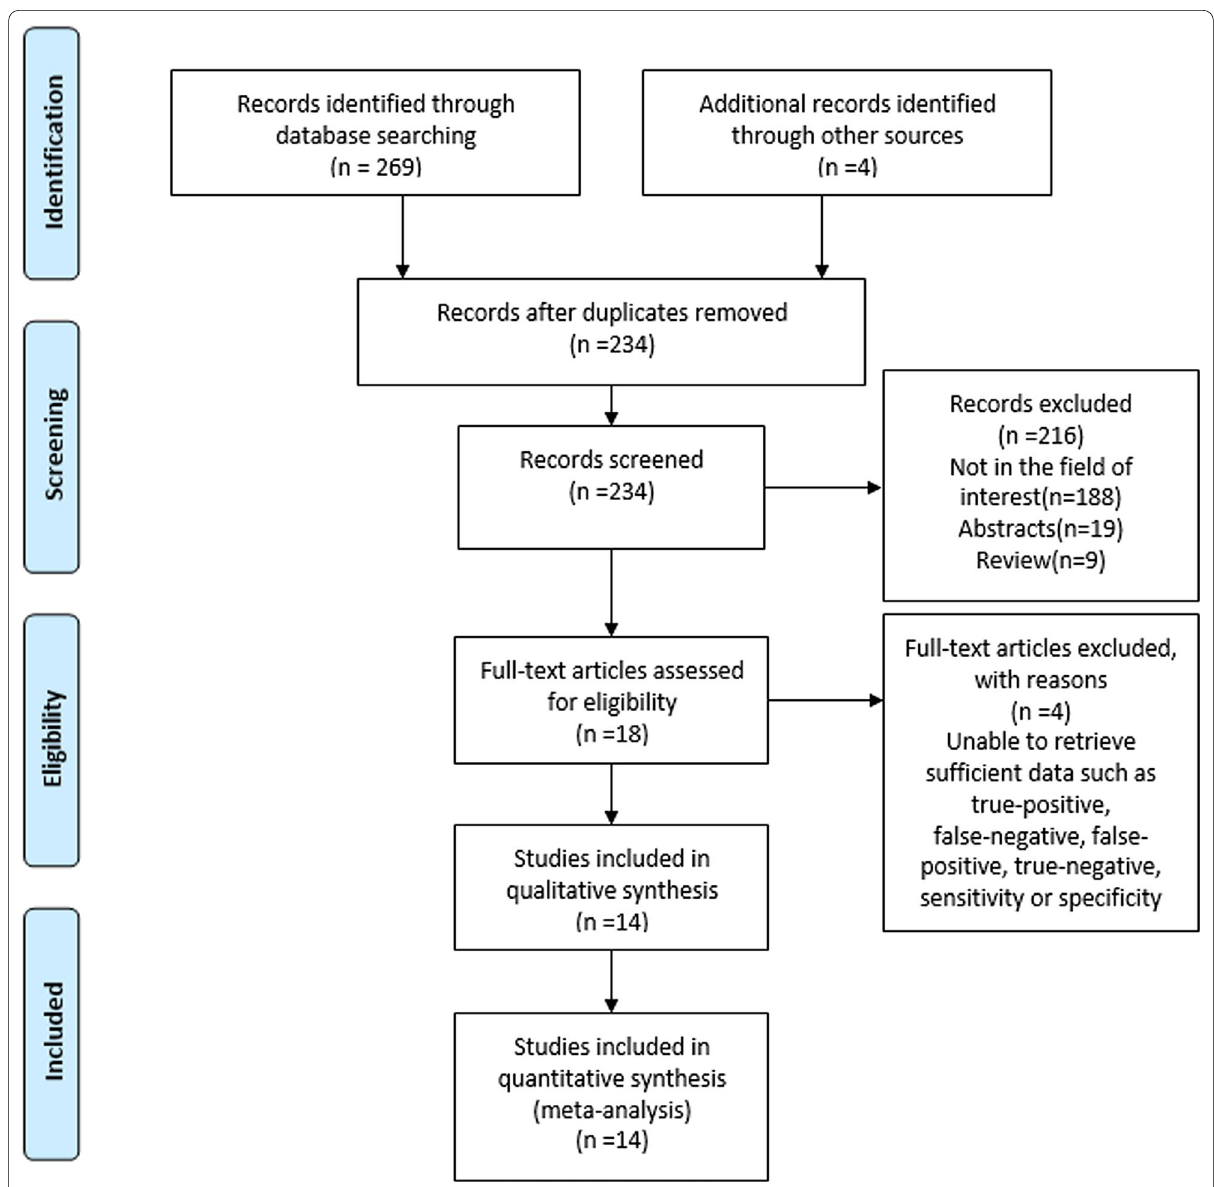
Fig. 1 A flow diagram of the literature review and study